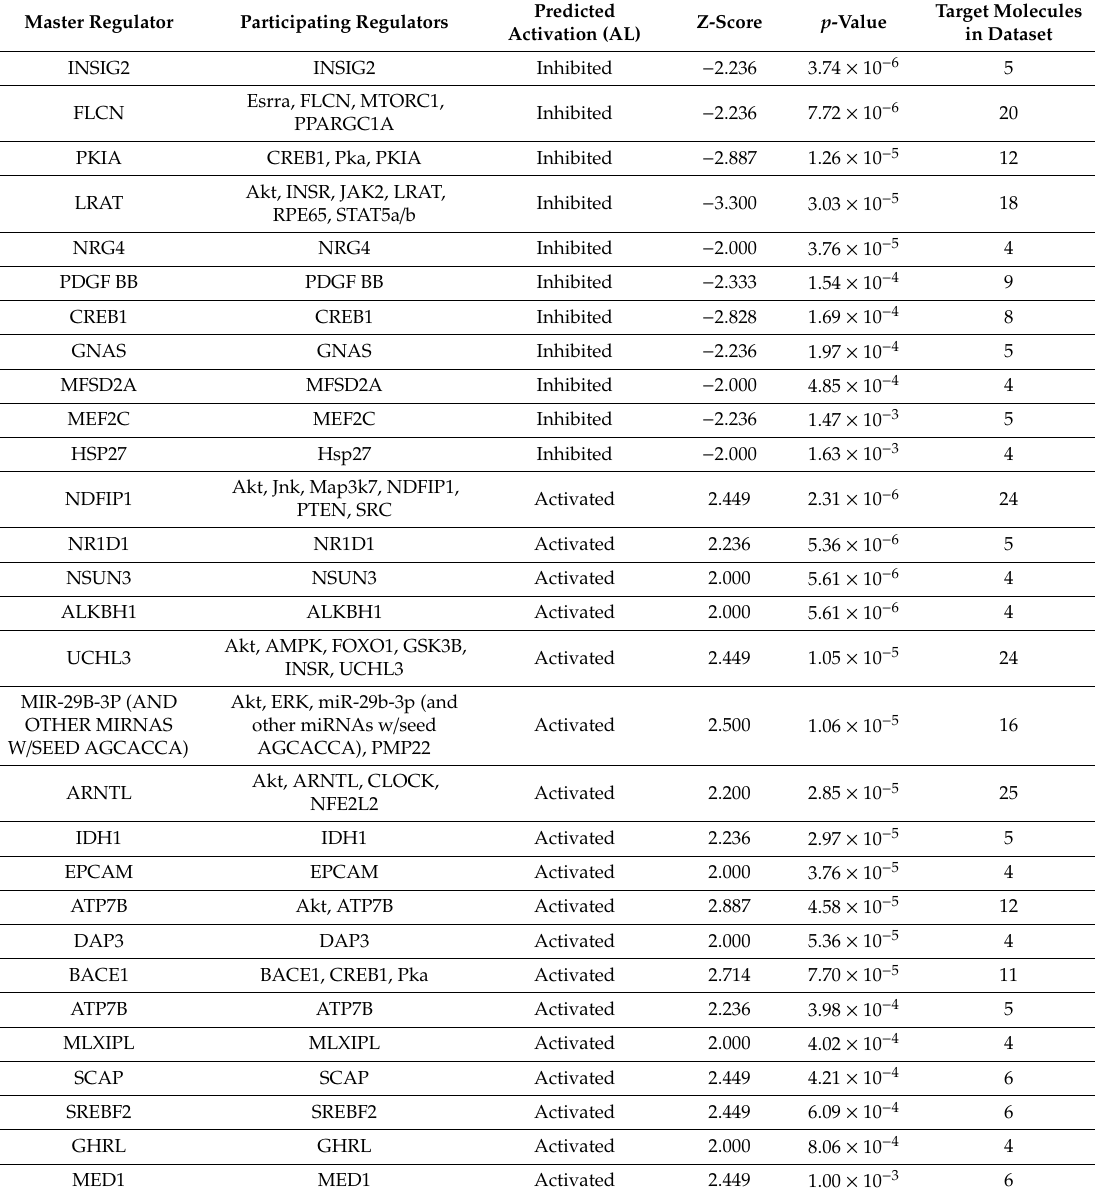
Table 2. Causal regulator e ff ects predicted to be activated and inhibited in